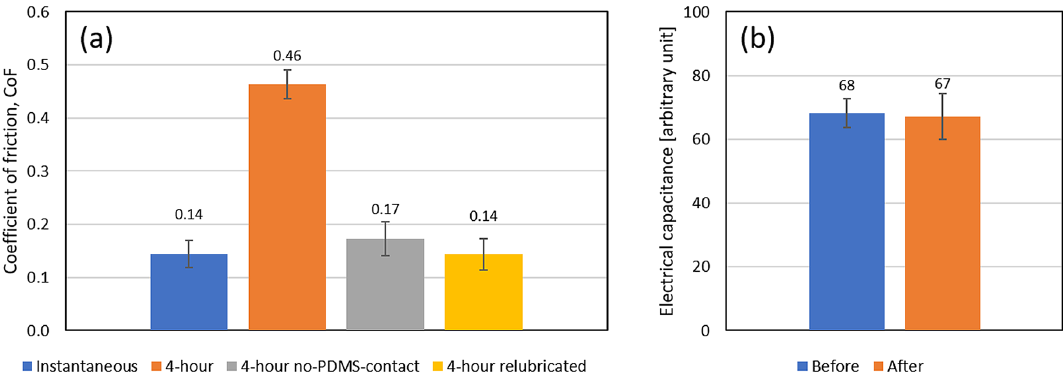
Figure 7. ( a ) Static CoF of 20BW40OO40MO and ( b ) electrical capacitance of stratum corneum before and four hours after the application of 20BW40OO40MO. 20BW40OO40MO represents a lubricant that contains 20 wt% beeswax, 40 wt% olive oil, and 40 wt% mineral